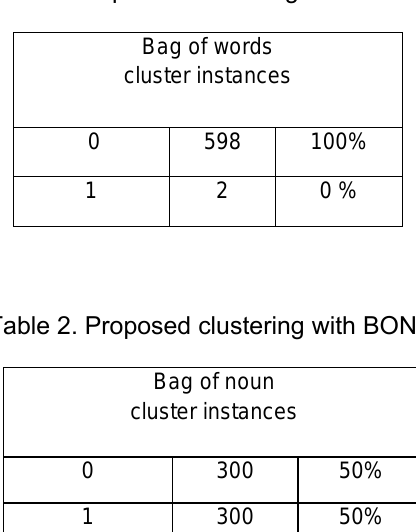
Table 1. Proposed Clustering with BOW